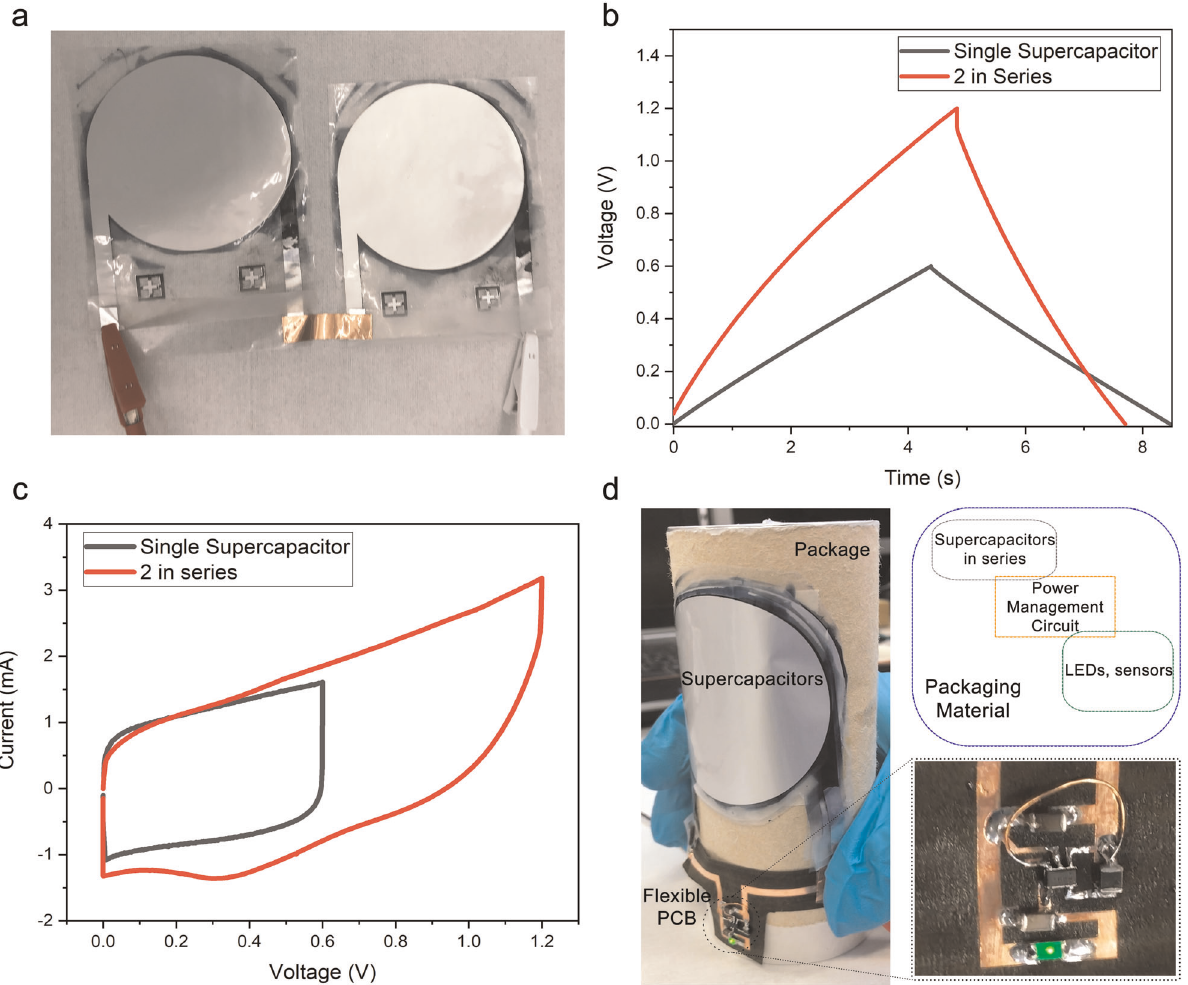
Fig. 4 Applications of the all printed-paper supercapacitors. a Image of two supercapacitors connected in series. b GCD measurement of two supercapacitor devices connected in series at 1.0 A/g current density. c CV measurement of two series connected devices at a scan rate of 10 mV/s. d Integrated system. LED is connected to boost converter circuit, which is powered by two serially connected supercapacitors on curved packaging